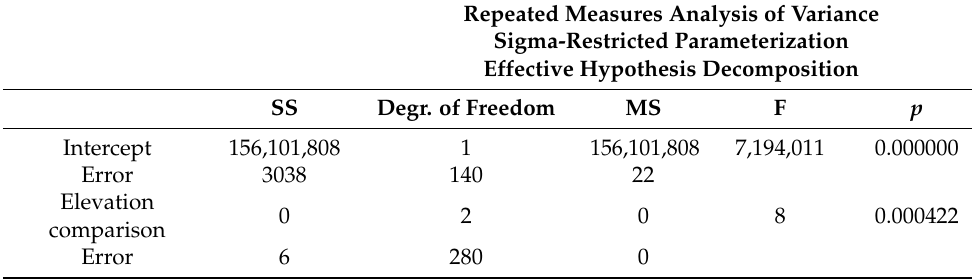
Table 3. Results of the analysis of variance for height points measured by GNSS, DTM, and